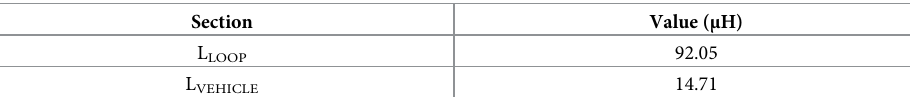
Table 5. Results for Citroe¨n AX.